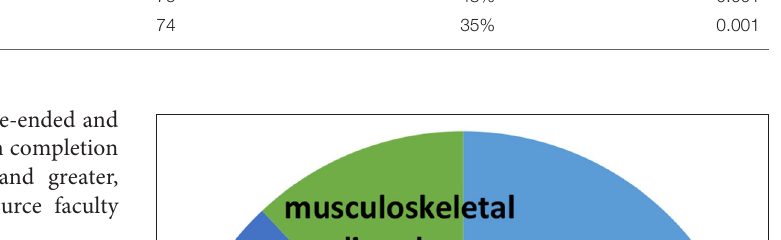
TABLE 1 | Category-wise pretest and posttest scores and total scores ( n = 351). Category % Score in pretest General safety and ergonomics